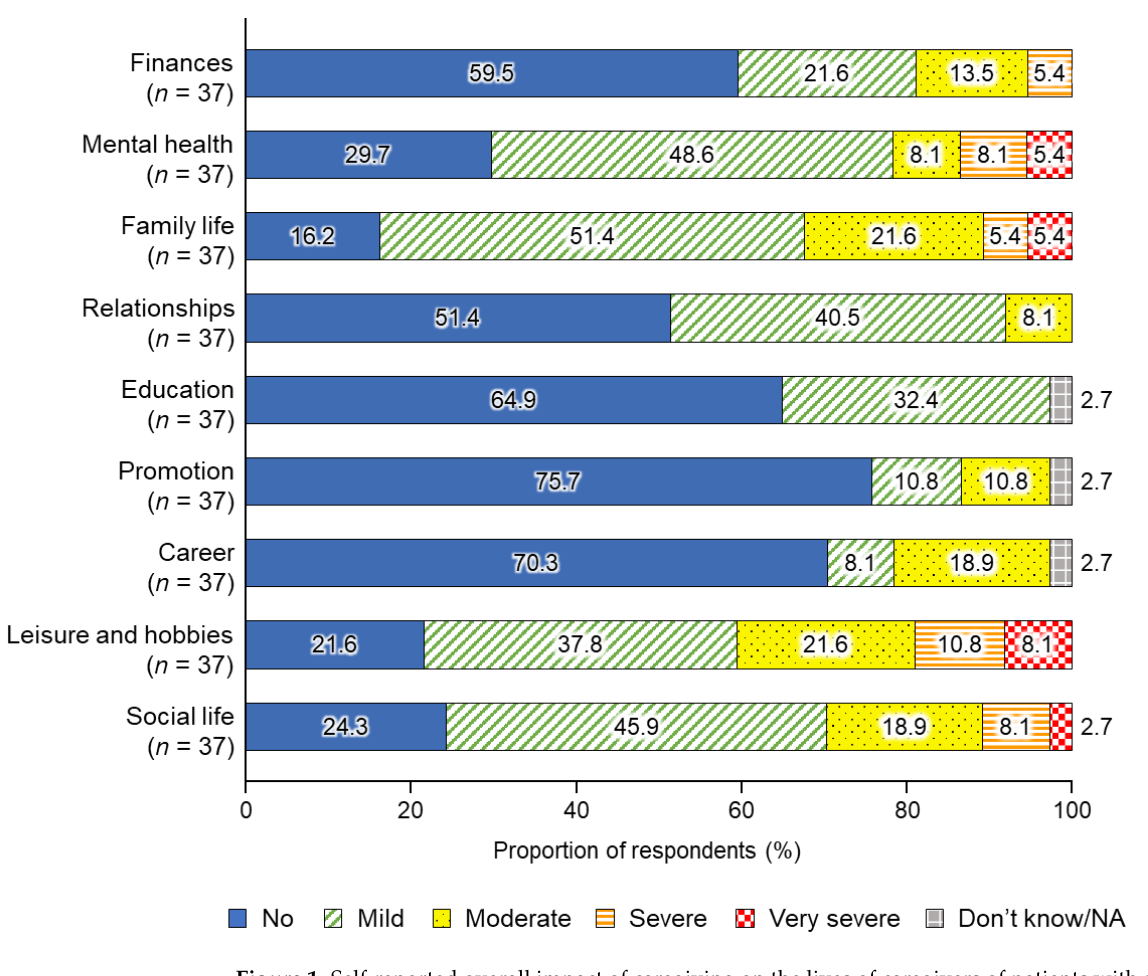
Figure 1. Self-reported overall impact of caregiving on the lives of caregivers of patients with retinitis pigmentosa. NA, not applicable.